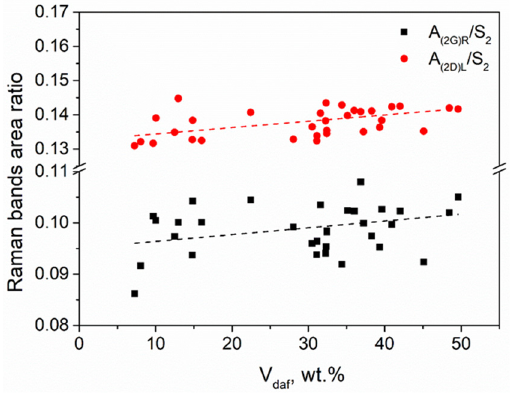
Figure 2. The correlation between V daf in parent coal and A (2G)R /S 2 and A (2D)L /S 2 of its pyrolytic